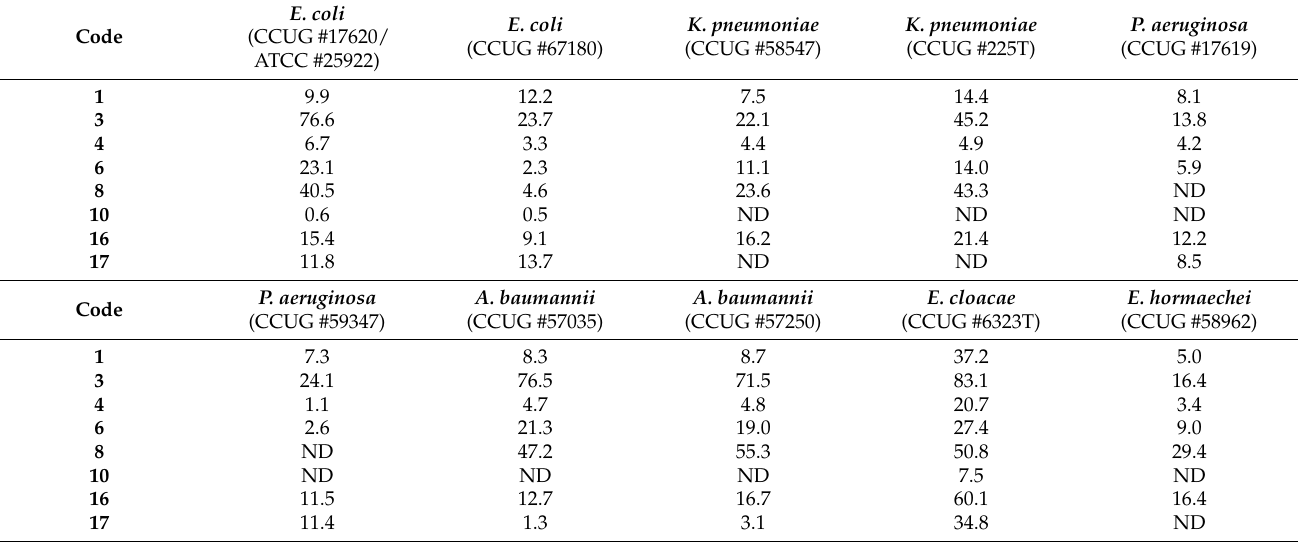
Table 3. Selectivity indices of each compound against the Gram-negative set of ESKAPE isolates and E. coli